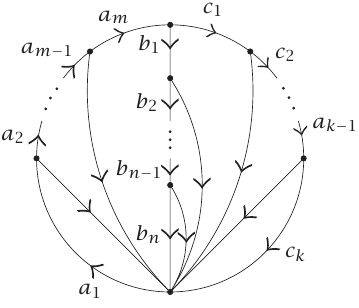
Figure 4.10 . Peacock diagram. The propagators without label are g ( 0 )